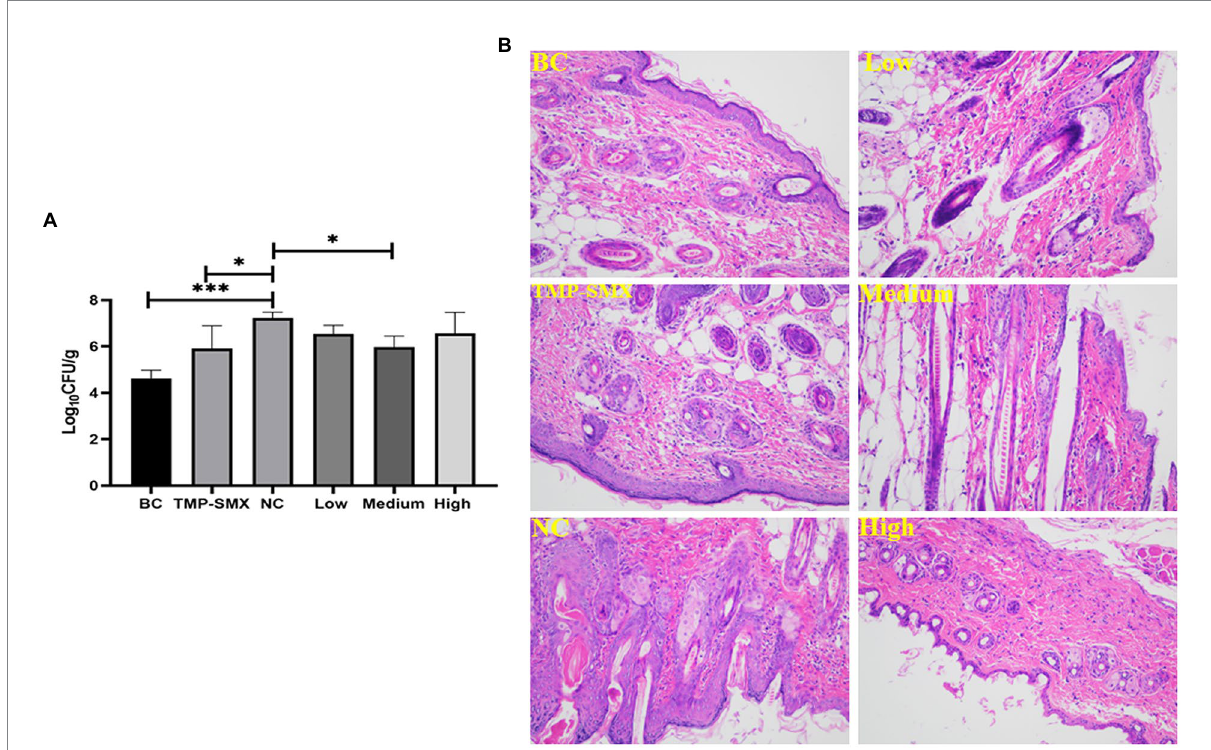
FIGURE 6 Effects of organic acid of Portulaca oleracea L. (OAPO) on skin wound bacterial load (A) and histopathology changes (B) on day 7 post-inoculation with Staphylococcus aureus MRSA85. *indicates p < 0.05, ***indicates p < 0.001. TMP-SMX: trimethoprim-sulfamethoxazole; BC: blank group, uninfected, no drug; NC: infected without the drug; low, medium and high means groups are given low, medium, and high dosages of OAPO, respectively.